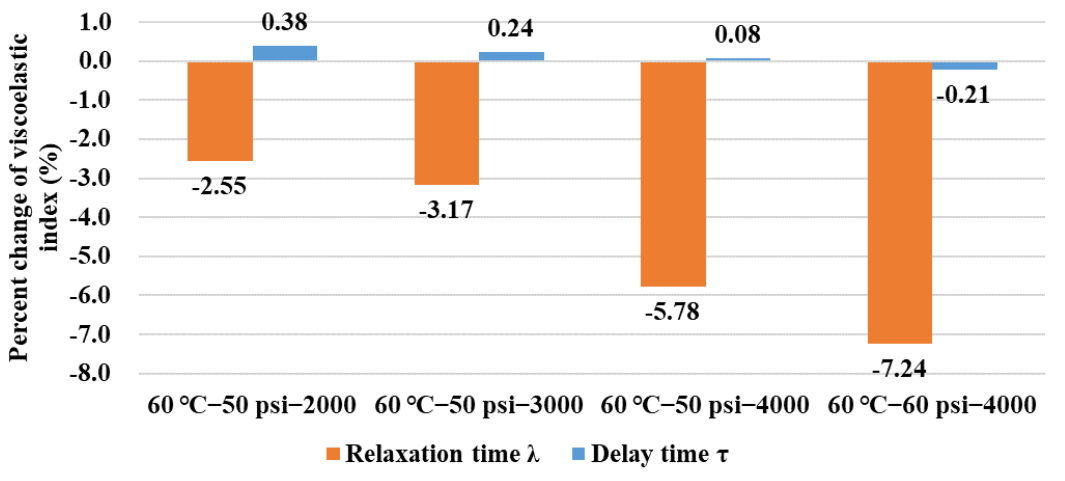
Figure 13. Percent change of viscoelastic indexes in BBR tests.